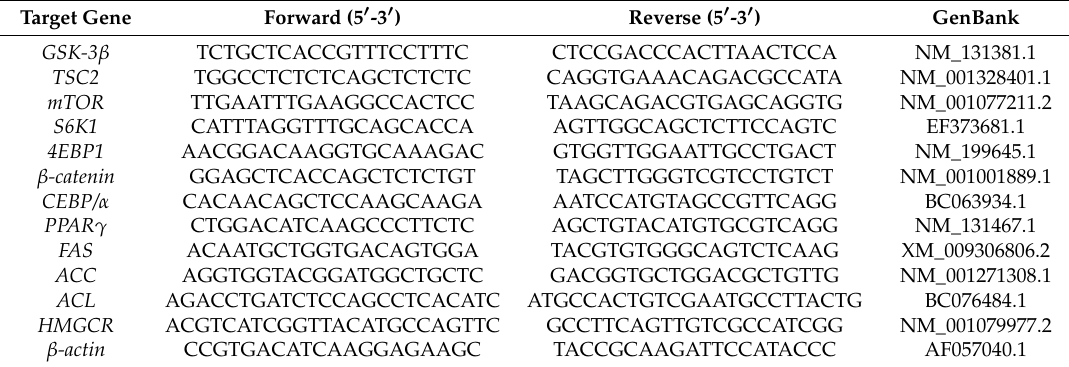
Table 2. Real-time quantitative PCR primers for genes of